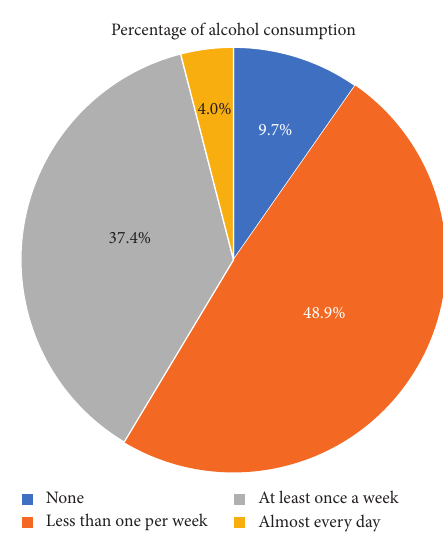
Figure 1: Frequency of alcohol consumption in the last 12 months among men who had ever taken a drink that contains alcohol in